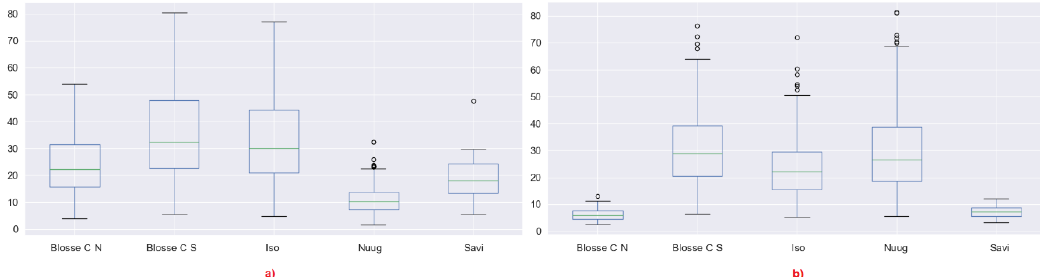
Figure 14. ( a ) Iceberg beta boxplot 5 × 5 window, ( b ) 11 × 11 window. Significant changes in beta are evident in Blosseville Coast N, Nuugaatsiaq and Savissivik.